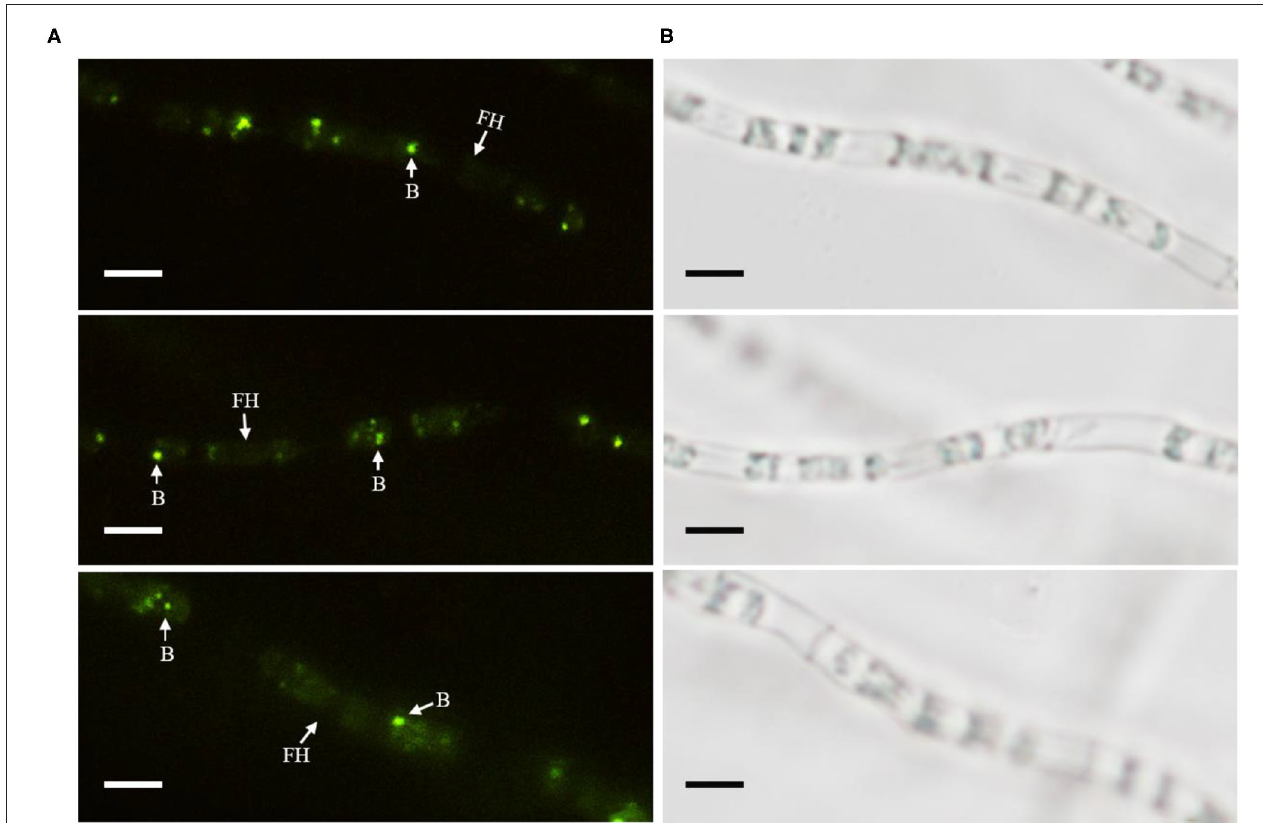
FIGURE 3 | GFP-labeled Klebsiella aerogenes localized in Fusarium oxysporum KB-3 hyphae. (A) Hyphae under fluorescence microscopy (left) (B) the same one under white light (right). Bars = 10 µ m.